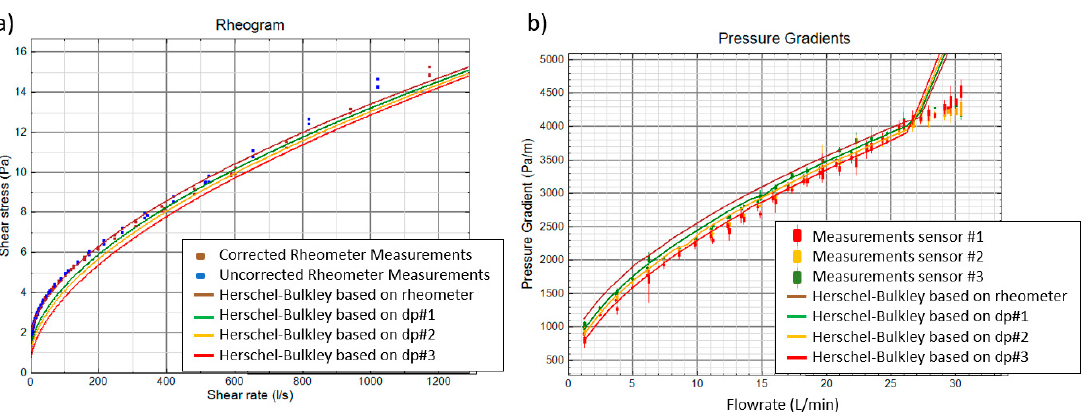
Figure 16. ( a ) Rheogram of an aqueous solution of xanthan gum and KCl measured at 25 °C with a scientific rheometer, ( b ) comparison between measured pressure gradients with the three differential pressure sensors and pressure gradients calculated with power law, Quemada and Heinz–Casson rheological behaviors.